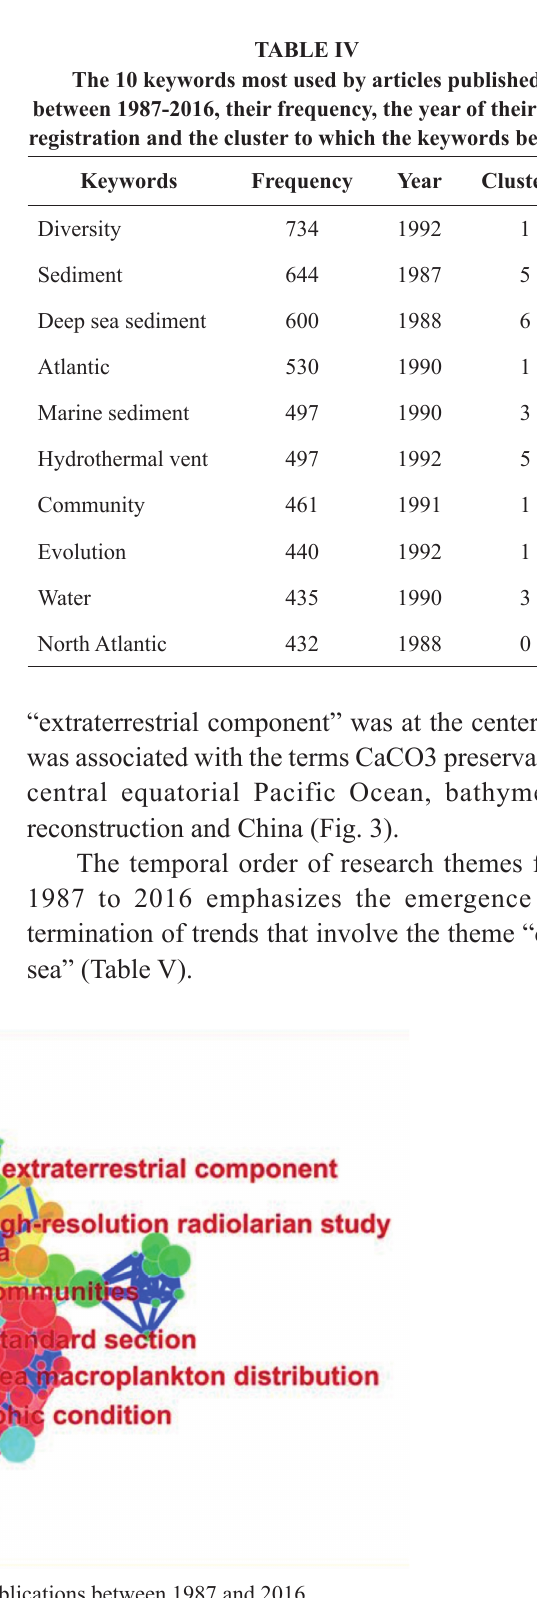
Figure 3 - Keyword clusters of deep sea publications between 1987 and